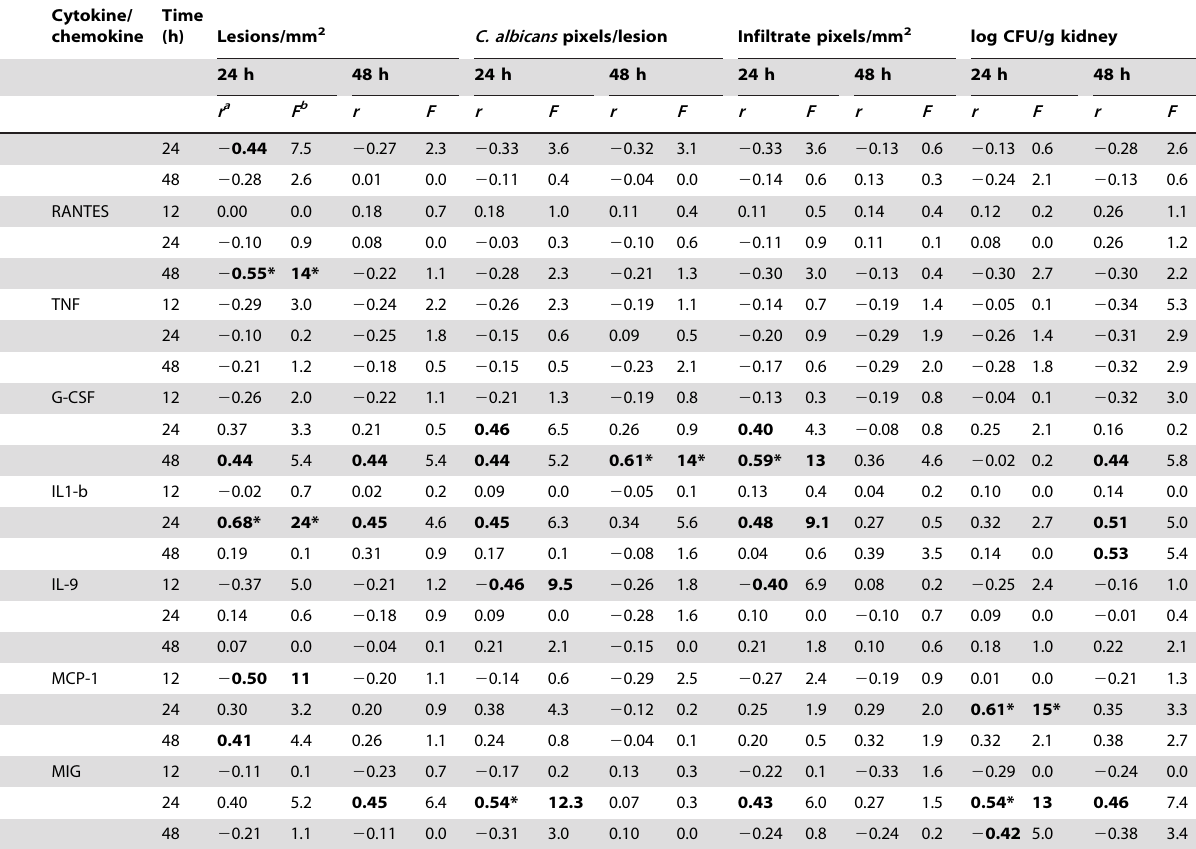
a r =Pearson correlation coefficient. b F =F-ratio from univariate analysis of variance. c data for mice infected with 8 of the 11 C. albicans isolates. All data presented to two significant figures. Boldface type indicates p , 0.01; an asterisk indicates p ,